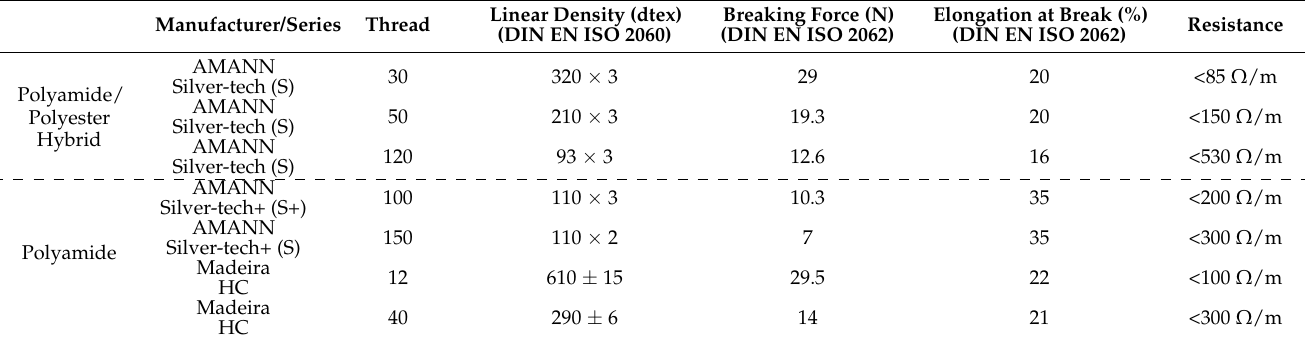
Table 1. Key thread parameters from manufacturer